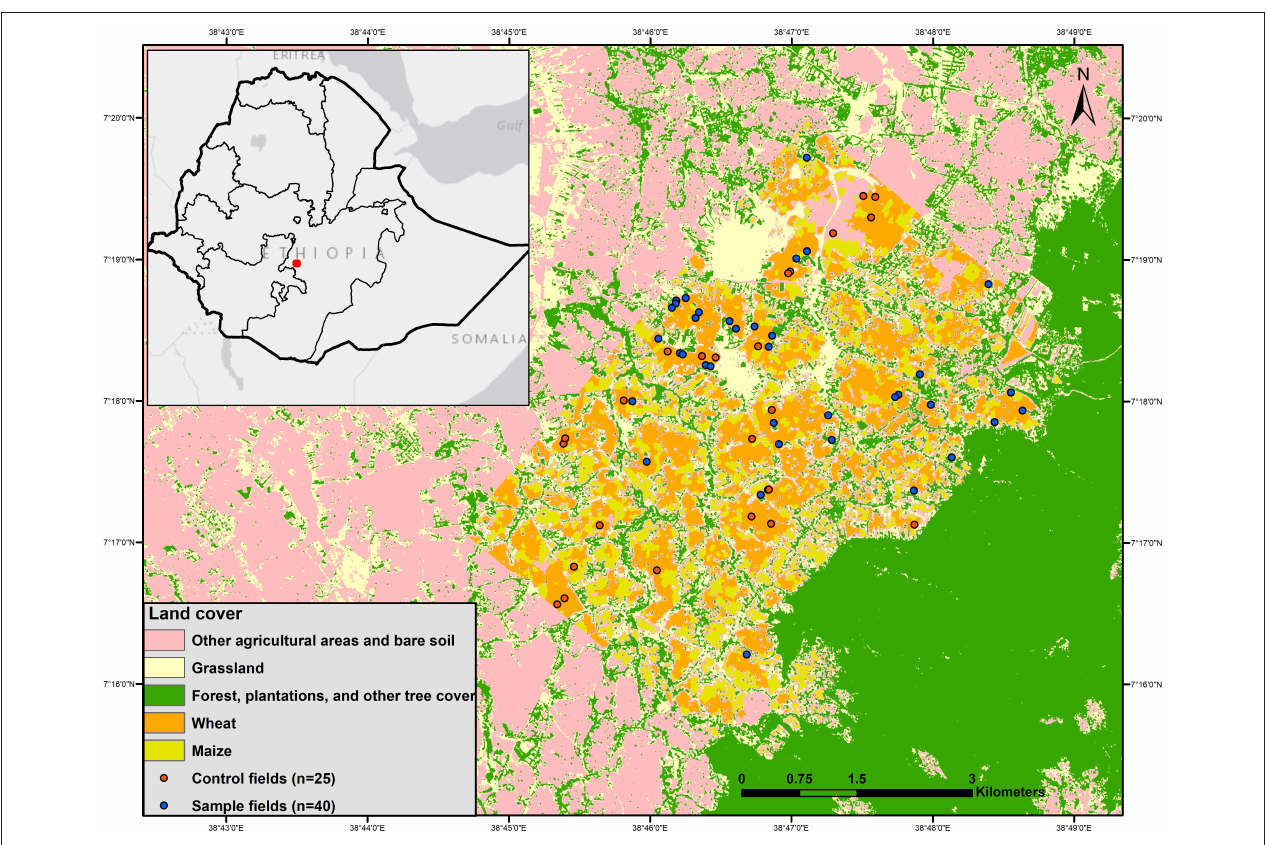
FIGURE 1 | Map of land cover classification in Arsi-Negele, Oromia, Ethiopia. Land cover is classified from 5m RapidEye imagery (“Forests, plantations, and tree cover,” “Grassland,” and “Other agricultural areas and bare soils”) and from 10m Sentinel-2 imagery (“Wheat” and “Maize”). Sample and control fields from the landscape are also shown as points